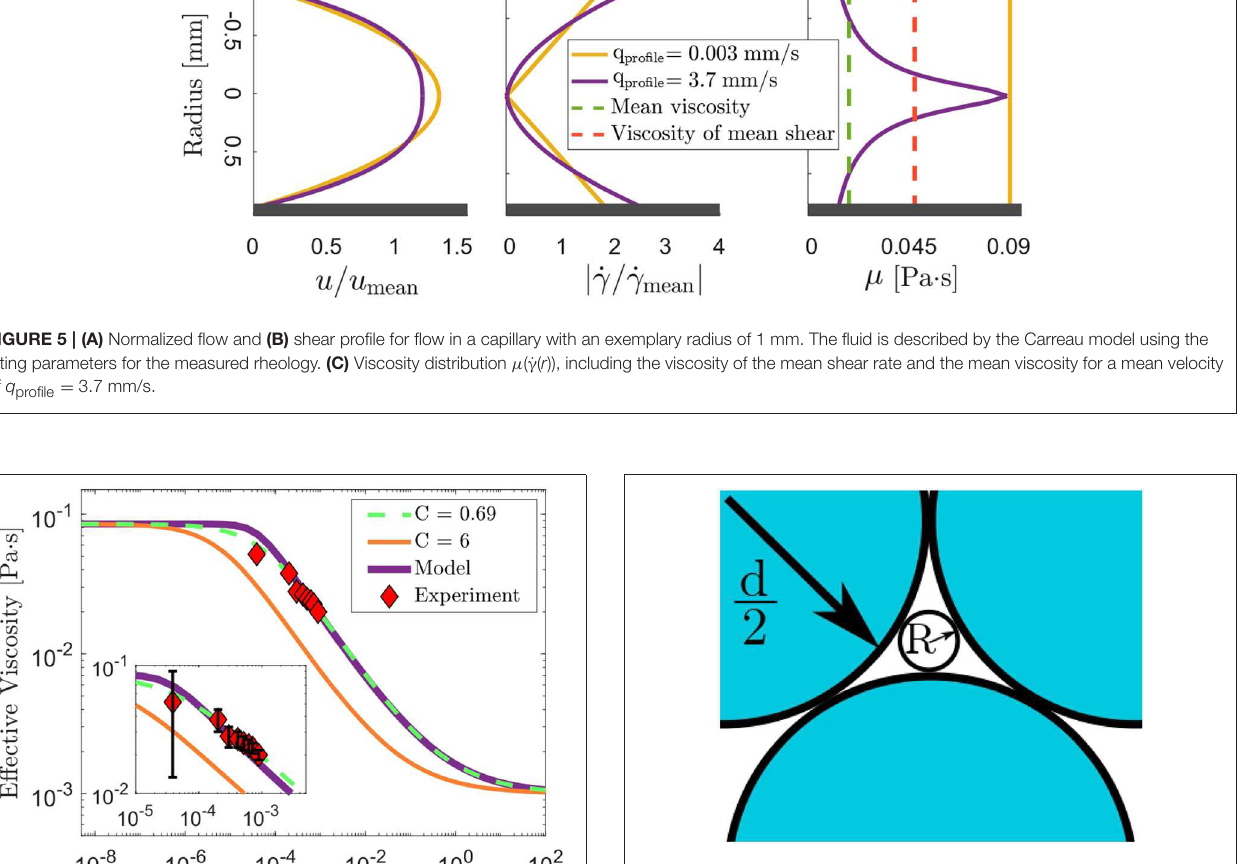
FIGURE 7 | Characteristic pore size with radius R between three glass beads with radius d / 2 (blue circles). and the power-law regime better than the previous